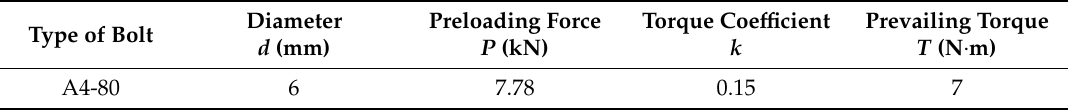
Table 4. Test parameters of the high strength bolt.